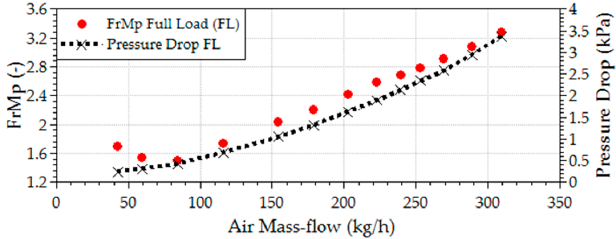
Figure 11. Evaluated FrMp of the air cleaner and the measured pressure drop depending on the measured air mass-flow at full load operating points.